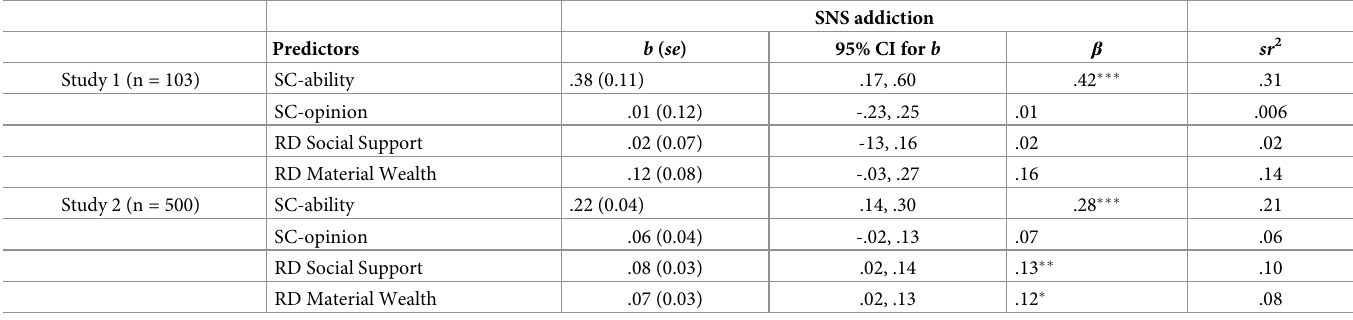
Table 7. Comparison of the identical regression models using samples in Study 1 and Study